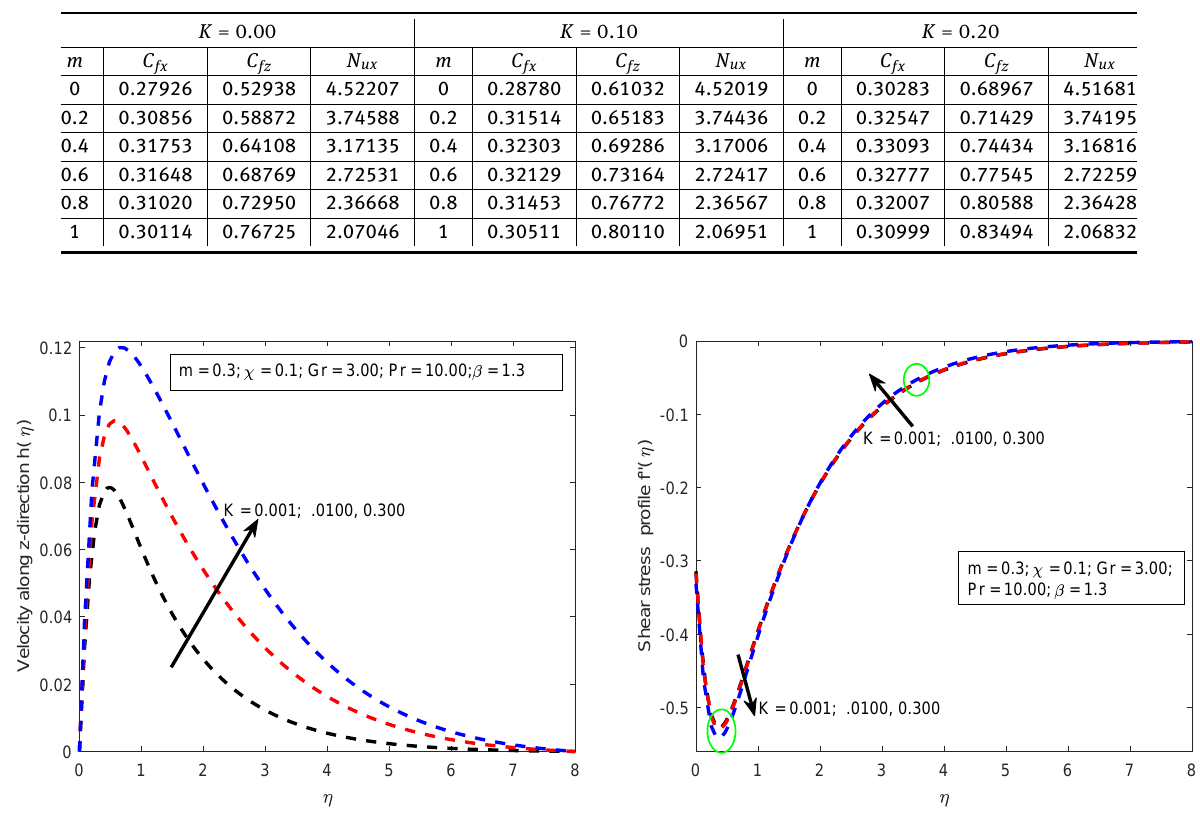
Figure 4: Variation of velocity profiles in the z -direction profile with rotation parameter